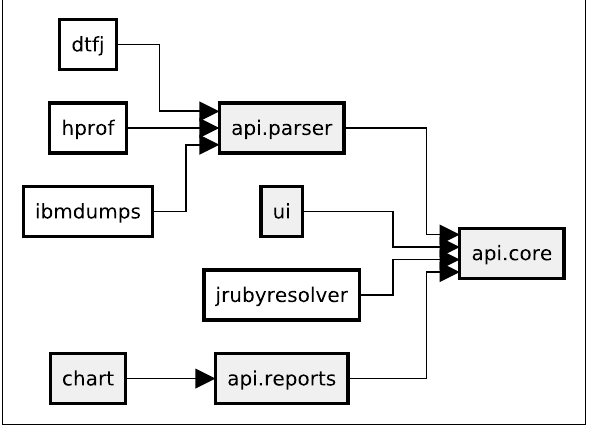
Figure 7: Evolved System